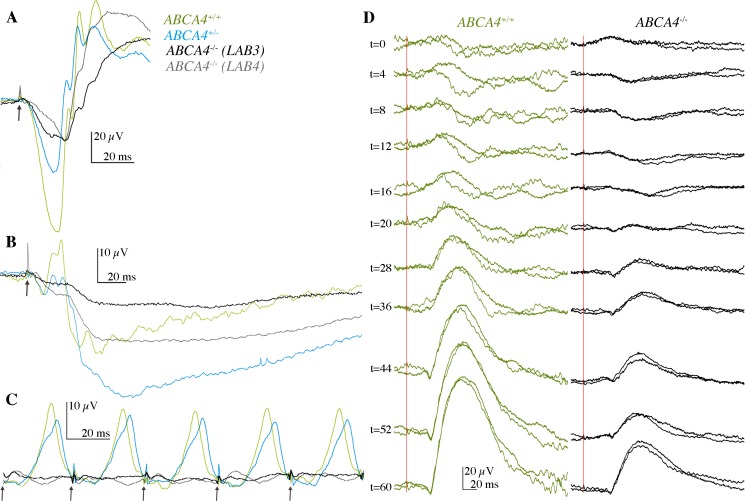
Flash-electroretinography (FERG) were used to assess retinal function in vivo.The green, blue, grey and black tracings indicate wild-type (LAB22; ABCA4+/+) unaffected dog, a heterozygous (LAB6; ABCA4+/-) dog, and two homozygous (LAB4 and LAB3; ABCA4-/-) affected dogs, respectively. Black arrows in A, B and C indicate 3 cd/m2/s-flash stimuli and the red line in D indicate 0.02 cd/m2/s-flash stimuli and scales show amplitude on the y-axis (μV) and time in ms on the x-axis for each type of response. (A) A dark-adapted, mixed rod-cone response. (B) Light-adapted cone transient responses (C) and cone flicker response at 30 Hz. Note that the affected dog had a delayed response to the stimuli. (D) The dark-adapted rod responses monitored during one hour in an affected (LAB3) and a wild-type female (LAB22).